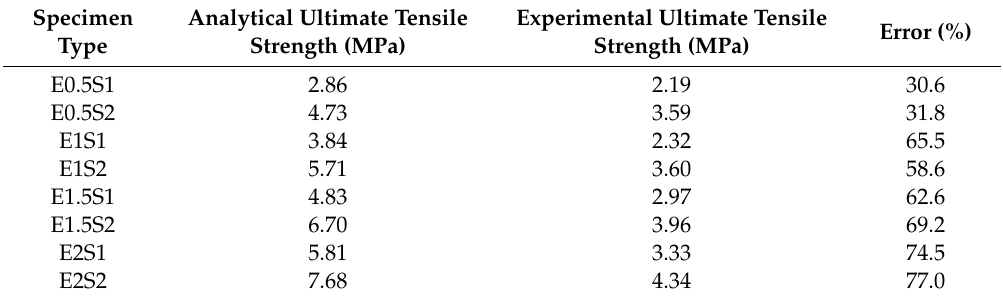
Table 10. Comparison of analytical and experimental ultimate tensile strengths of steel grid-PE fiber reinforced